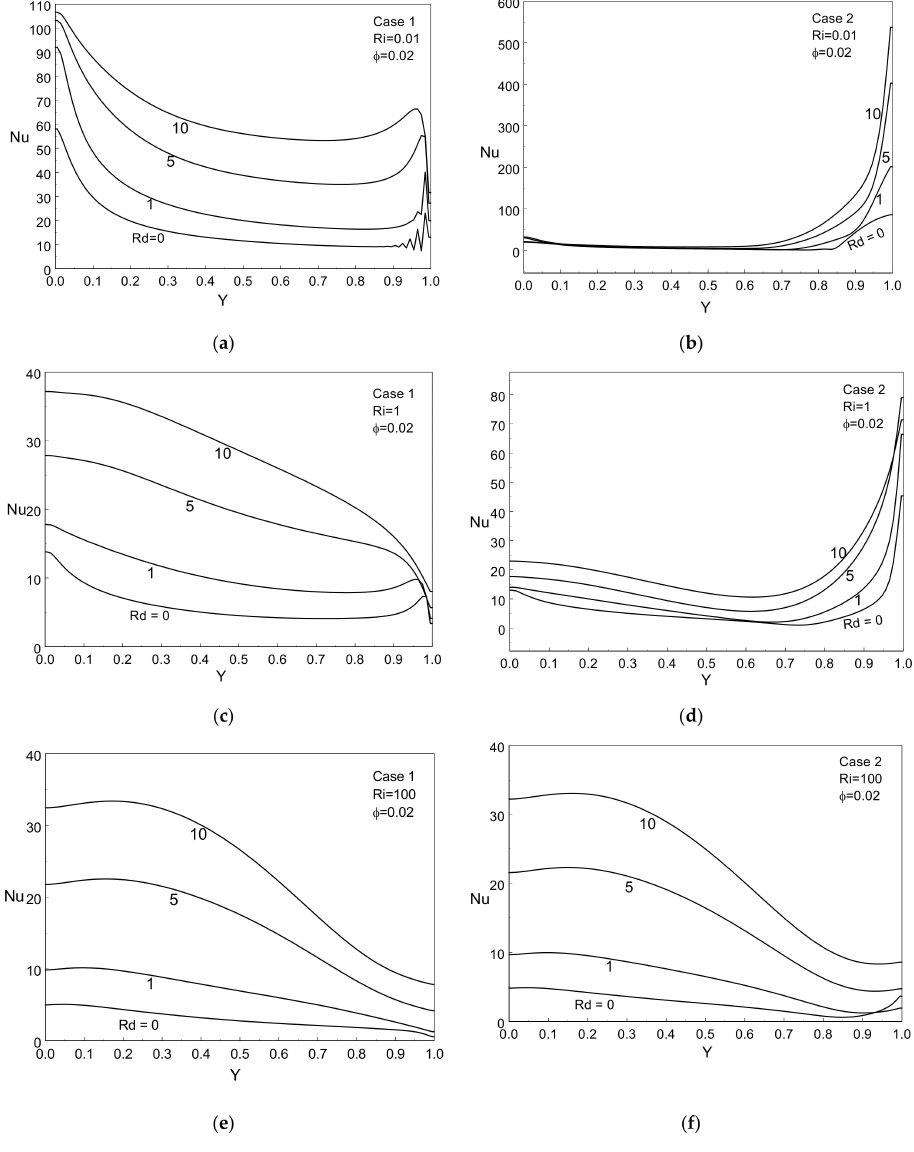
Figure 7. Local Nusselt number for diverse Ri and Rd. ( a , c , e ) Case 1; ( b , d , f ) Case